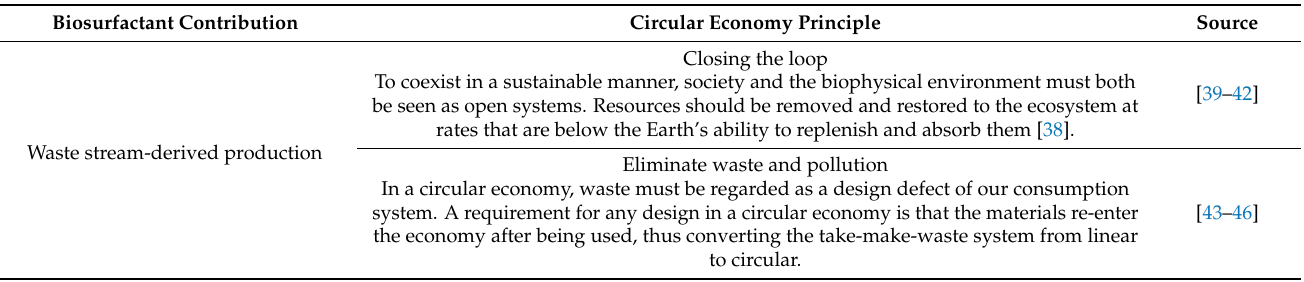
Table 2. Main contribution of biosurfactants to the circular